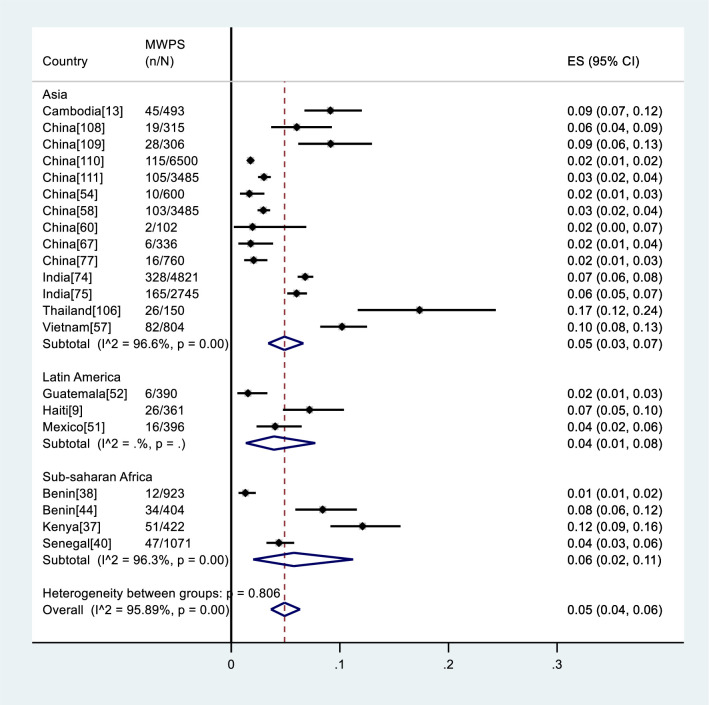
Meta-analysis of HIV prevalence among MWPS in LMICs by region.ES: Estimated prevalence, n: Number of HIV positive, N: Number of samples.